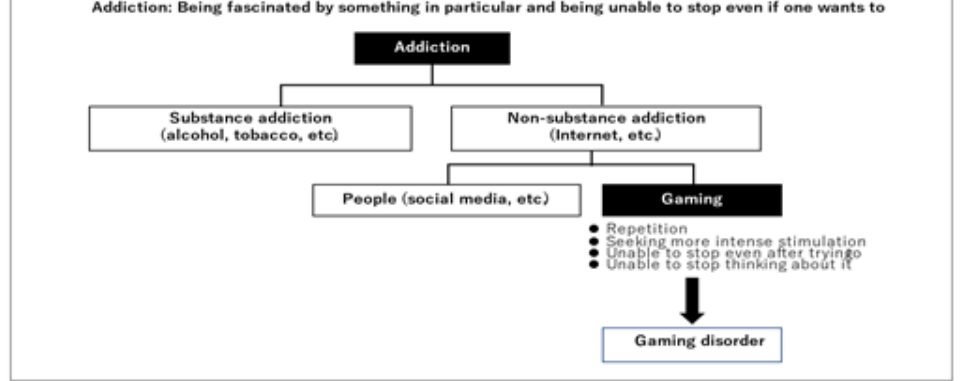
Figure 1. Two kinds of addiction: what is gaming disorder?